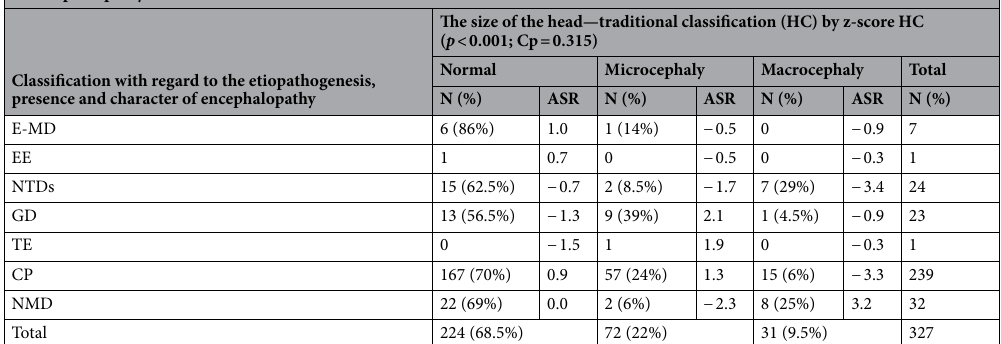
Table 3. The size of the head—traditional classification (HC) and (A) units and syndromes associated with neurodysfunction, (B) classification with regard to the etiopathogenesis, presence and character of encephalopathy. N numbers of patients; % percent; p probability value calculated by chi-square test of independence, Cp Pearson’s Contingency Coefficient C, Cp ≥ 0, values distant from 0 reflect some relationship, values approaching 1 correspond to a perfect association; ASR adjusted standardized residuals, values > 1.96 reflect a greater number, and those below < − 1.96 correspond to a smaller number than a random